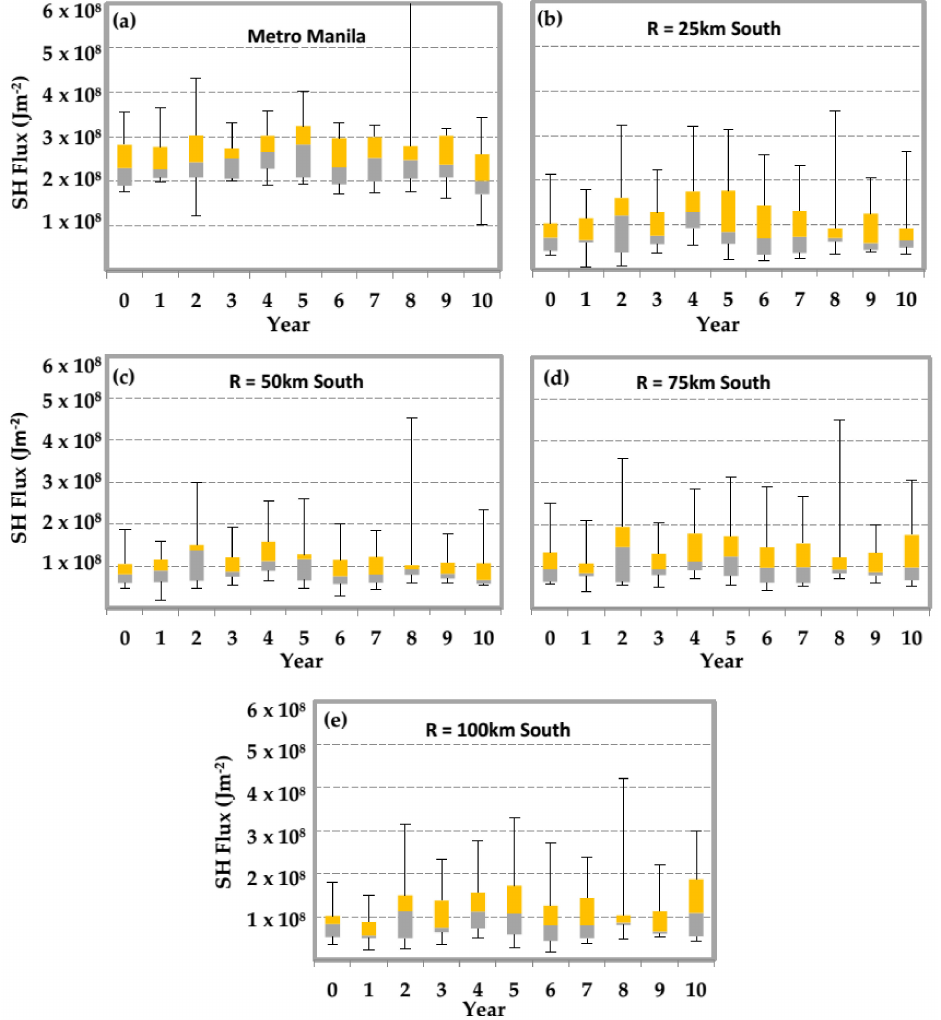
Figure 2. Annual variation of sensible heat (SH) flux of Metro Manila ( a ) and selected places in the south of Manila ( b – e ) for the period 2000–2010. Figure 2a is the same as Figure